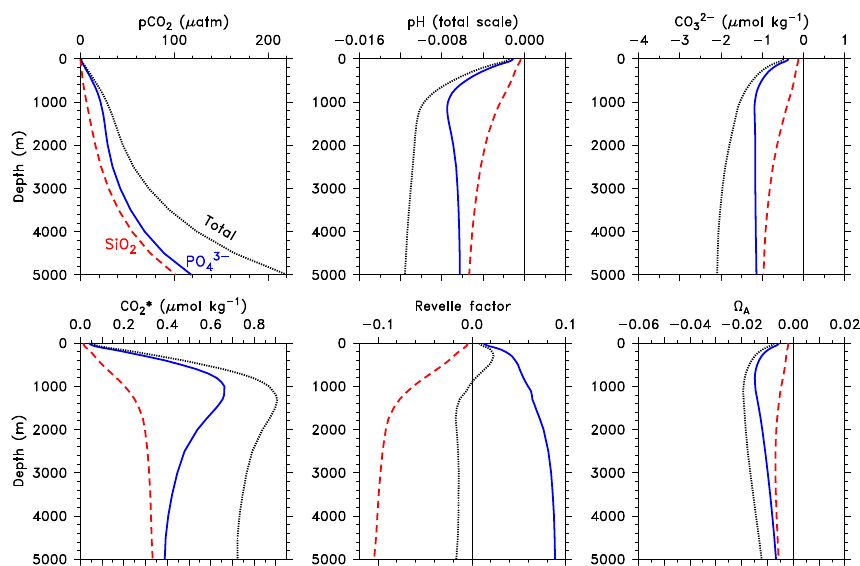
Figure 11. Absolute changes in global-mean profiles of computed variables attributable to nutrient alkalinity, i.e., for the same components shown in Fig.